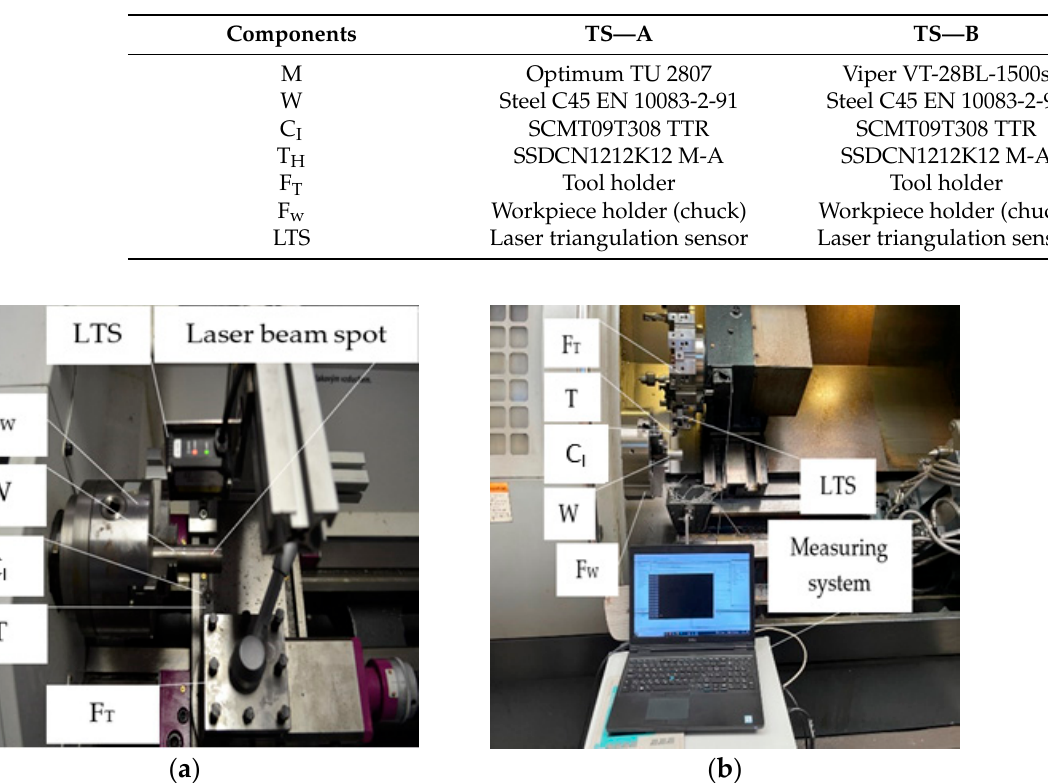
Figure 1. ( a ) Working zone and general view of the Optimum TU 2807 machine; ( b ) working zone and general view of the Viper VT-28BL-1500s with FANUC Series 21i—TB control system.